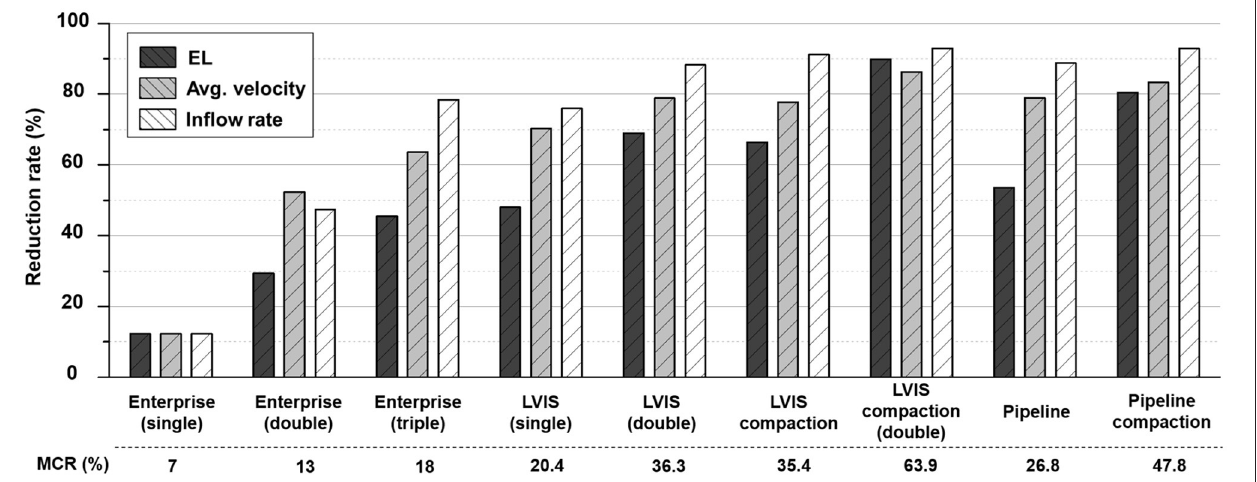
FIGURE 2 | Comparison of the MCR and reduction rates for the hemodynamic parameters according to the overlapping and compaction of Enterprise, LVIS, and Pipeline devices. MCR, metal coverage rate.